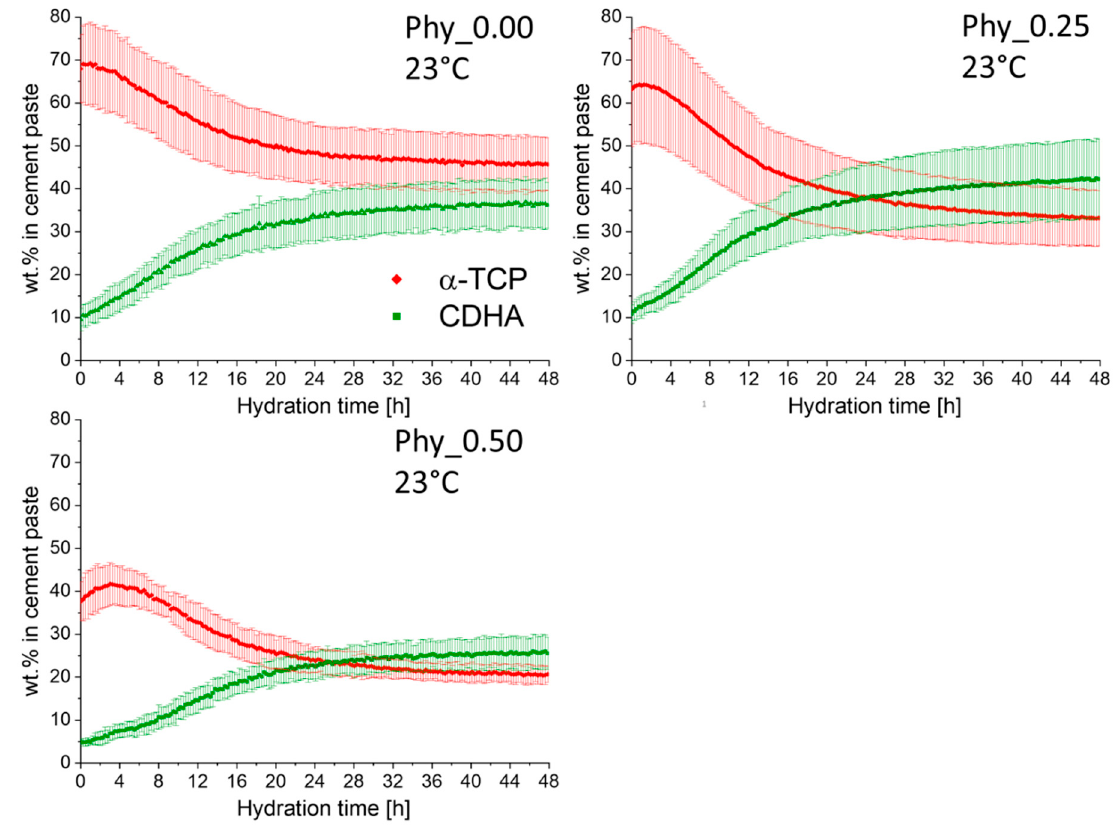
Figure 8. The quantitative in-situ XRD results of samples composed of α –TCP and CDHA (weight ratio 9:1) with different amounts of sodium phytate; a 0.2 M Na 2 HPO 4 aqueous solution was used as the mixing liquid with an L/P of 0.3 ml/g Powder . The measurements were performed at T = 23 °C; three independent measurements were run for each sample, and the error bars represent the standard deviation.